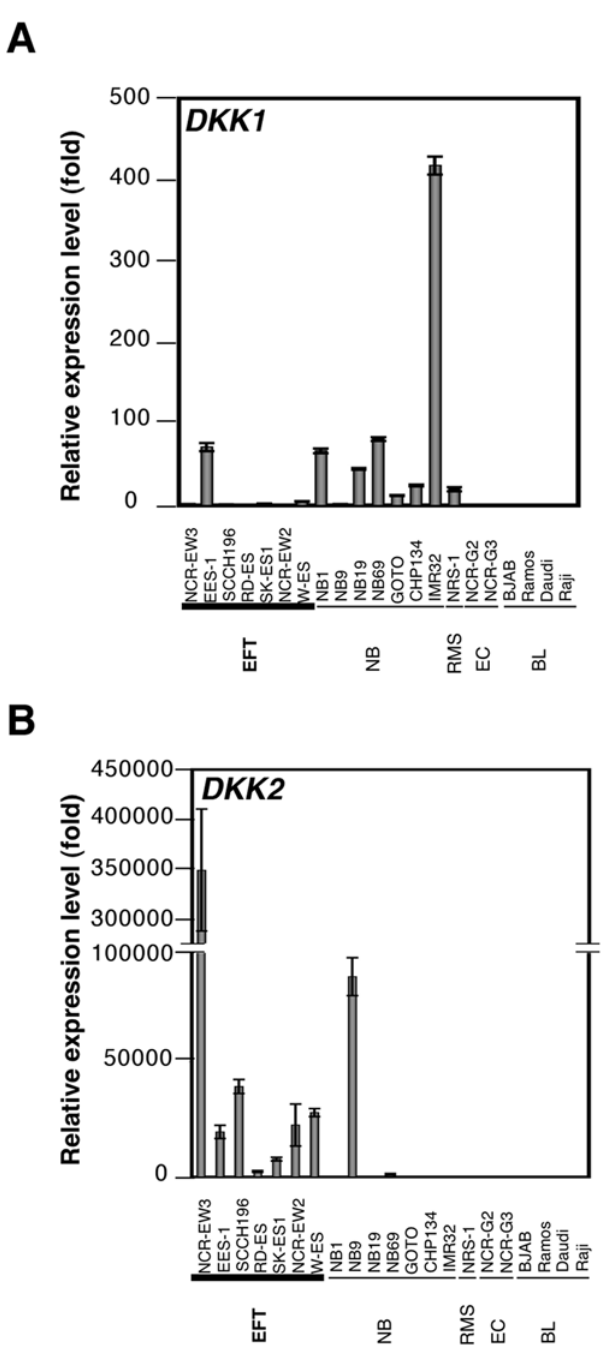
Figure 1. The expression pattern of the DKK family in Ewing’s family tumor (EFT). A , B , Real-time RT-PCR analysis using pediatric tumor cell lines for DKK1 ( A ) and DKK2 ( B ) expression. EFT: Ewing’s family tumor, NB: neuroblastoma, BL: Burkitt lymphoma, RMS: Rhabdomyosarcoma, EC: embryonal carcinoma. Data are normalized to the mRNA level in SCCH196 (for DKK1) and Ramos (for DKK2) which is arbitrarily set to 1. Signal intensity was normalized using that of a control housekeeping gene (human GAPDH gene). Data are relative values with the SD for triplicate wells.